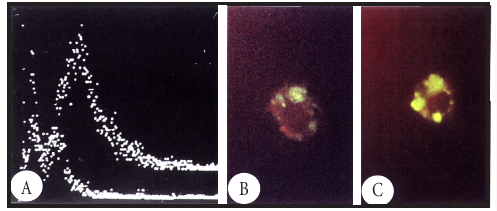
Figure 2: Panel (A) shows the fluorescence intensity vs. relative cell number, obtained using BALB/c mouse macrophages incubated at 4 ◦ CwithTc52andtreatedwithrabbitanti-Tc52antibodiesfollowed by fluoresceine-conjugated goat anti-rabbit Ig (right peak, 78% flu- orescent cells). The left peak represents cells which were incubated intheabsenceof Tc52andtreatedwiththeantibodiesasabove(12% fluorescent cells). Panel (B) shows that Tc52“sticks”to macrophages upon its interaction with these cells at 37 ◦ C. Panel (C) represents a high magnification of the same cell preparation after incubation with Tc52. The clumps of staining could be inside the cells or could be capped Tc52 that is on the upper surface of the cell.